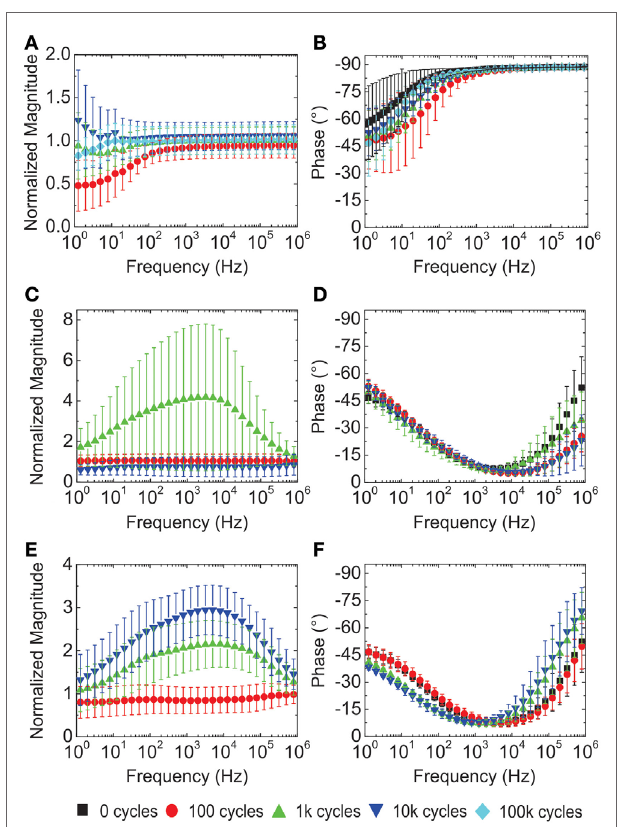
FigUre 13 | lateral impedance from (a,B) PMP, (c,D) PMaP, and (e,F) PaMaP Parylene cables (mean ± se, n = 16) . Magnitude of impedance was normalized to the impedance of the device at 0 cycles (PMAP and PAMAP were only bent for 10k cycles).